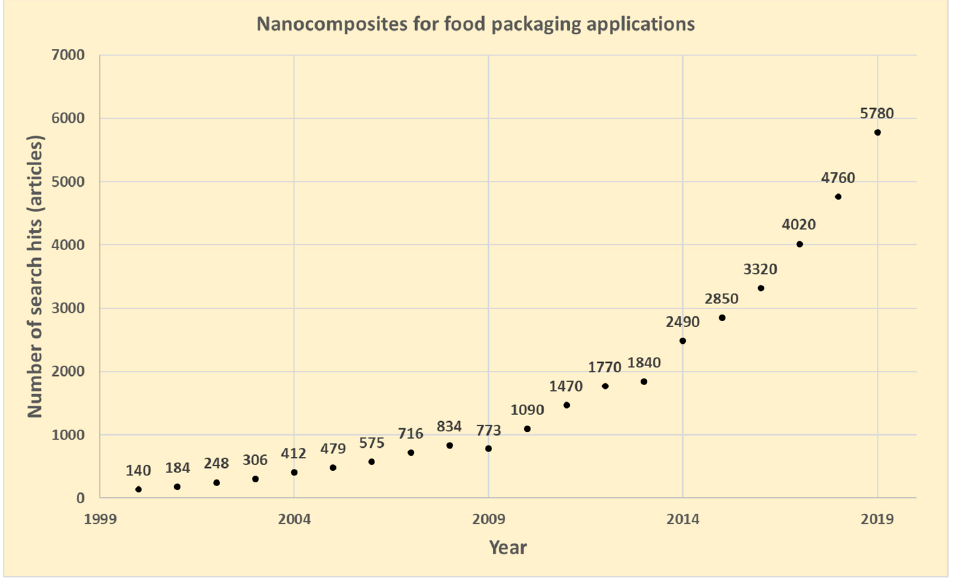
Figure 1. Number of annual publications related to nanocomposites for food packaging applications (searching with Google Scholar on 18 June 2020 with the following keywords: nanocomposites, food packaging).